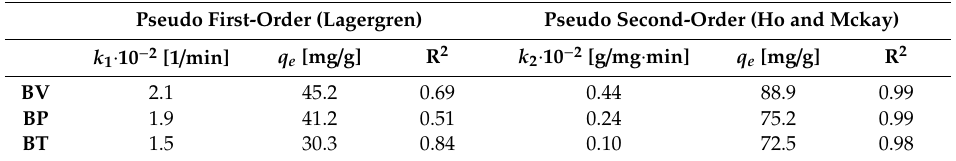
Table 2. Kinetic parameters of Ag-NP adsorption on biochars ( q e -Ag-NP removal capacity at equilibrium ; k 1 , k 2 - reaction rate constants).